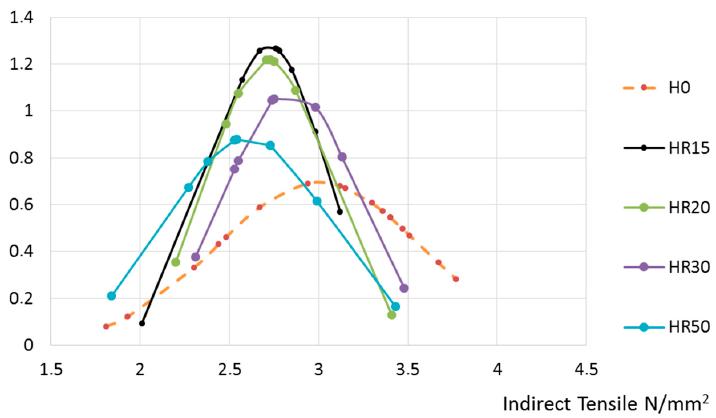
Figure 8. Concrete manufactured with recycled aggregates from Hormigones Rioja.